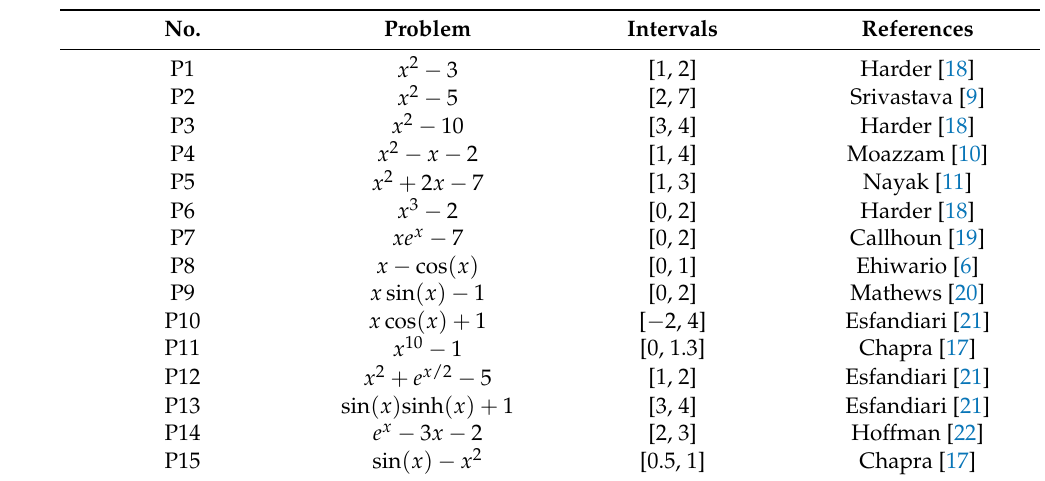
Table 1. Fifteen benchmark problems.